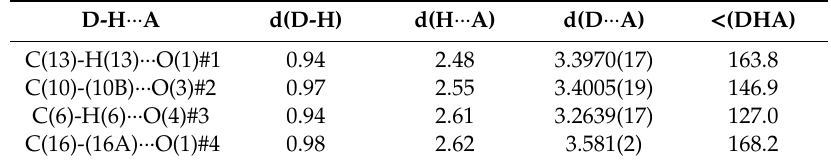
Figure 3. Pairs of hydrogen bonds form an inversion dimer ( A ) which are linked into chains along the b-axis ( B ). Table 3. Intermolecular hydrogen bonds for isoflavone 6 [Å and ◦